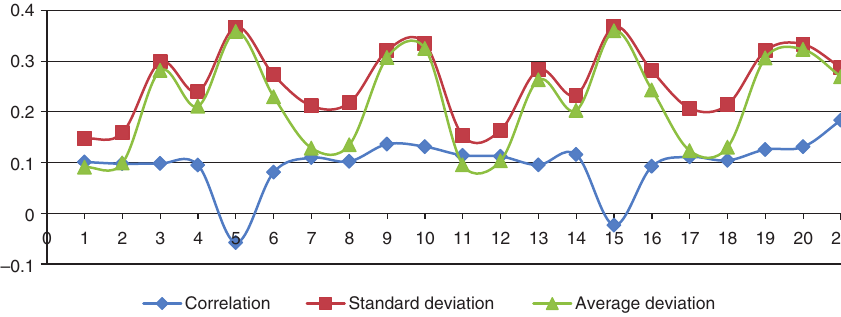
Figure 16: Results for Kaggle Brief Question Answer Evaluation Data Set for Score Class (3–4).